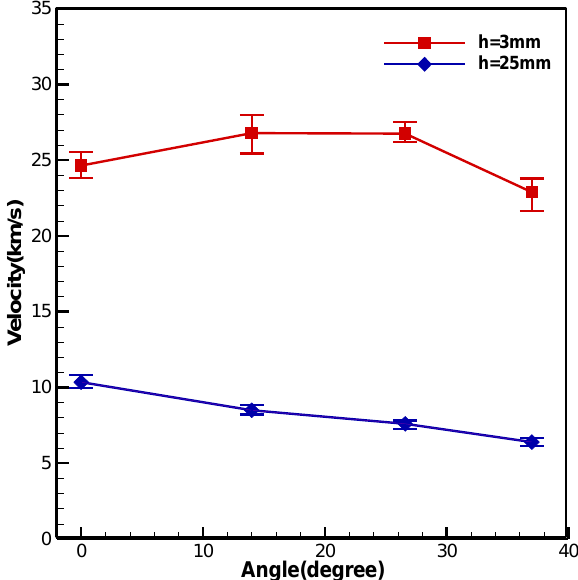
Figure 10. The variation of the average velocity of the ablative propellant with the flare angle of the rectangular electrode.